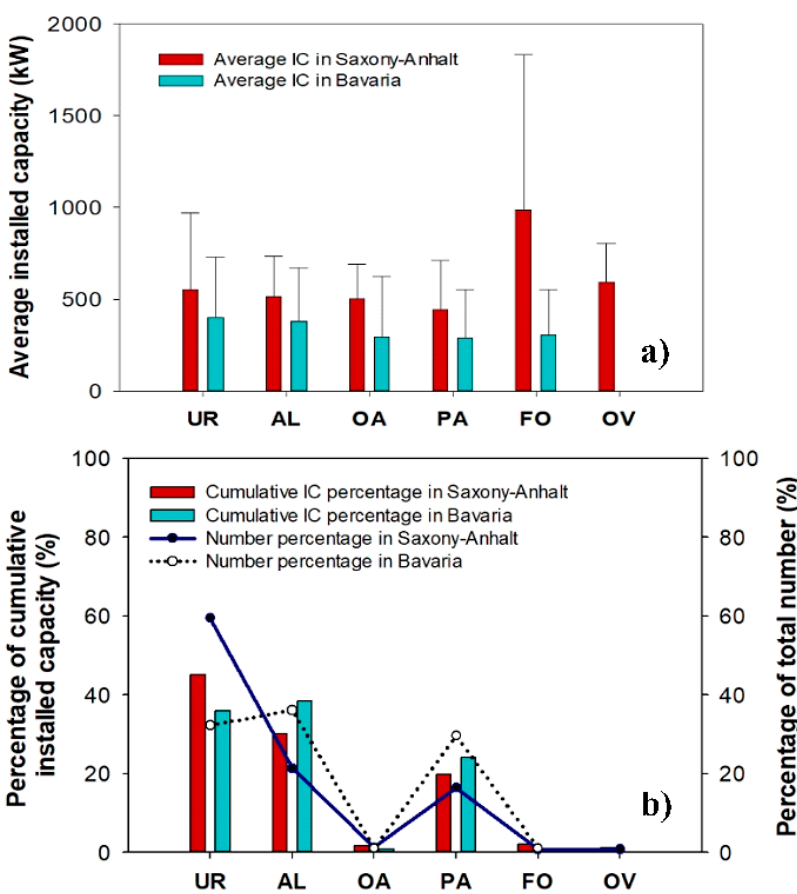
Figure 3. The biogas production development until 2015: ( a ) the distribution of averaged installed capacity (IC) on different land-use types; ( b ) the proportions of cumulative installed capacity and biogas plants on different land-use types in Saxony-Anhalt and Bavaria. Note: UR: urban area, AL: arable land, OA: other agricultural land, PA: pastures, FO: forest, OV: other vegetated land. Source: EE-Monitor, CLC 2000, and CLC 2018.